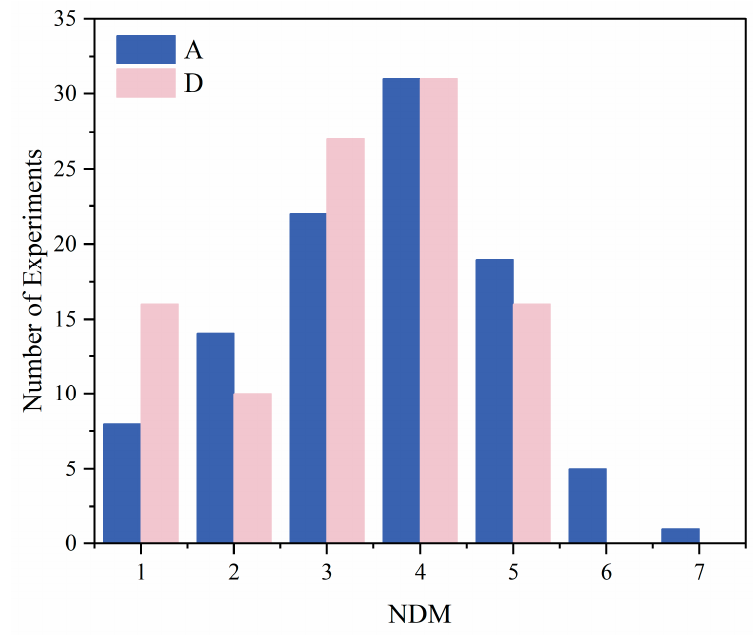
Figure 11. NDM in A and D ( t = 100).